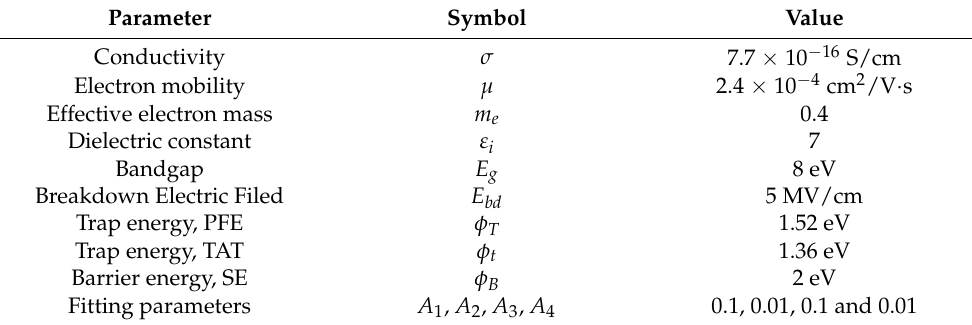
Table 1. Extracted parameters from Ig - Vg measurement to AL 2 O 3 MIS